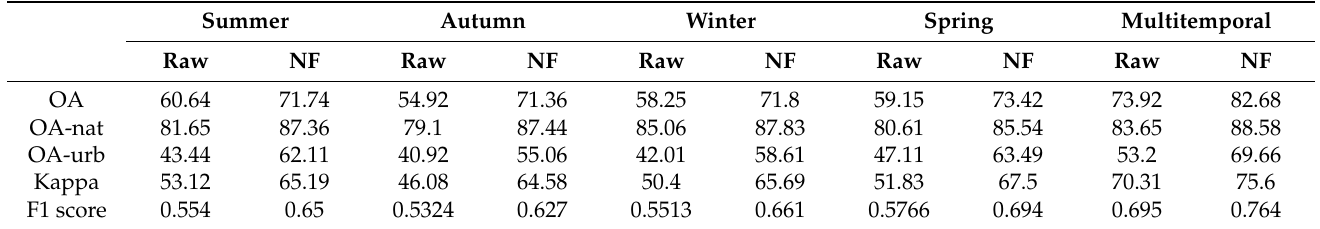
Table 6. Thohoyandou accuracy metrics for SI and MT raw and NH with local customized training.